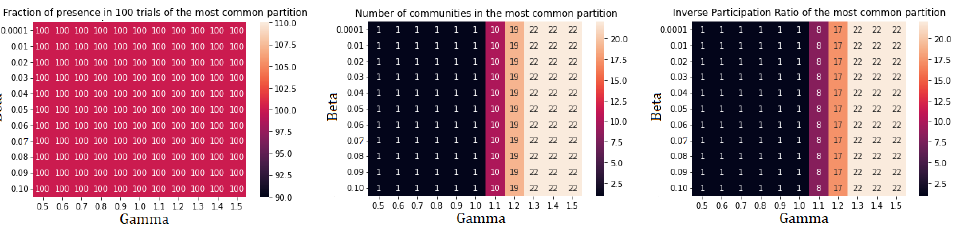
Figure A9. Performance indicators for Leiden algorithm applied to community I. There is no fur- ther subdivision.